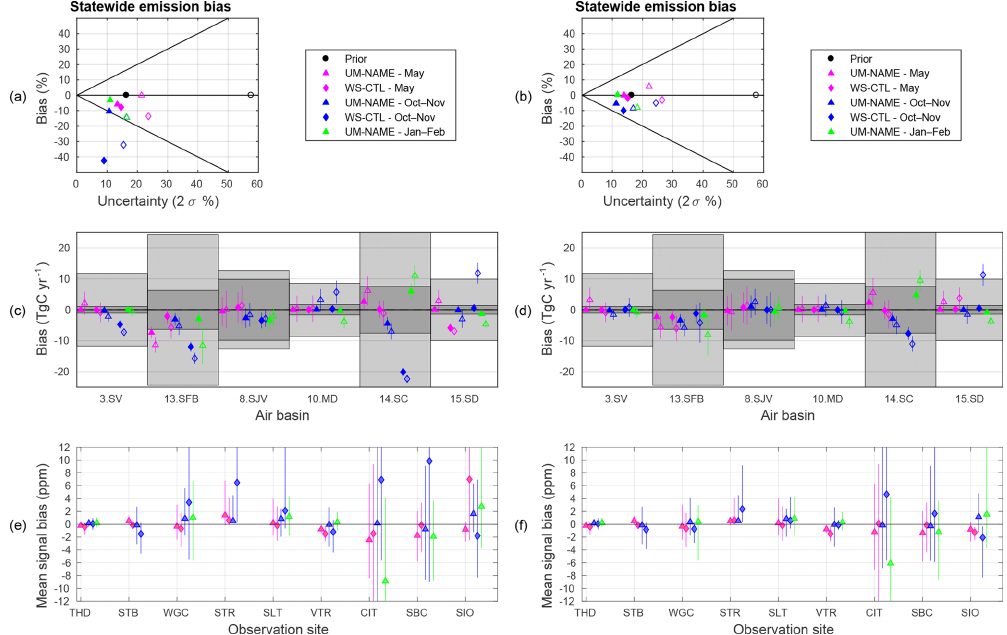
Figure 6. Inversion results for the experiment where the atmospheric transport in the prior simulation uses WS-CTL or UM-NAME, but the atmospheric transport in the true simulation uses WS-LBL. Posterior statewide emissions (a, b) , individual air basin emissions (c, d) , and percentage error in simulated average ffCO 2 concentration (e, f) are shown with no outlier removal (a, c, e) and outliers removed (b, d, f) . Prior and true emissions are given by annually averaged Vulcan